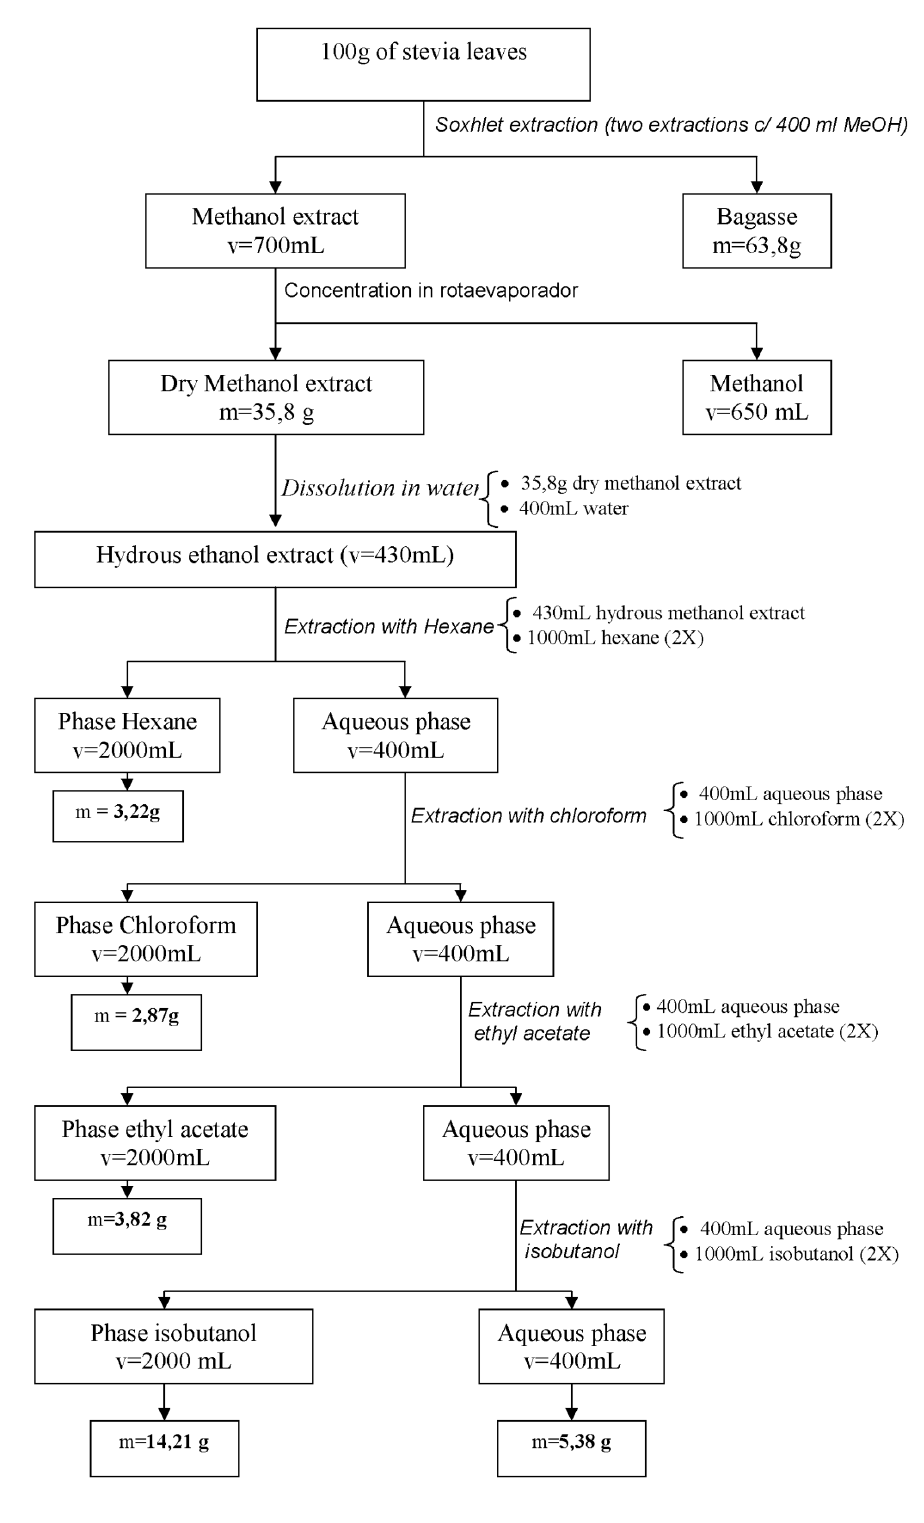
Figure 1 - Flow chart for obtaining stevia